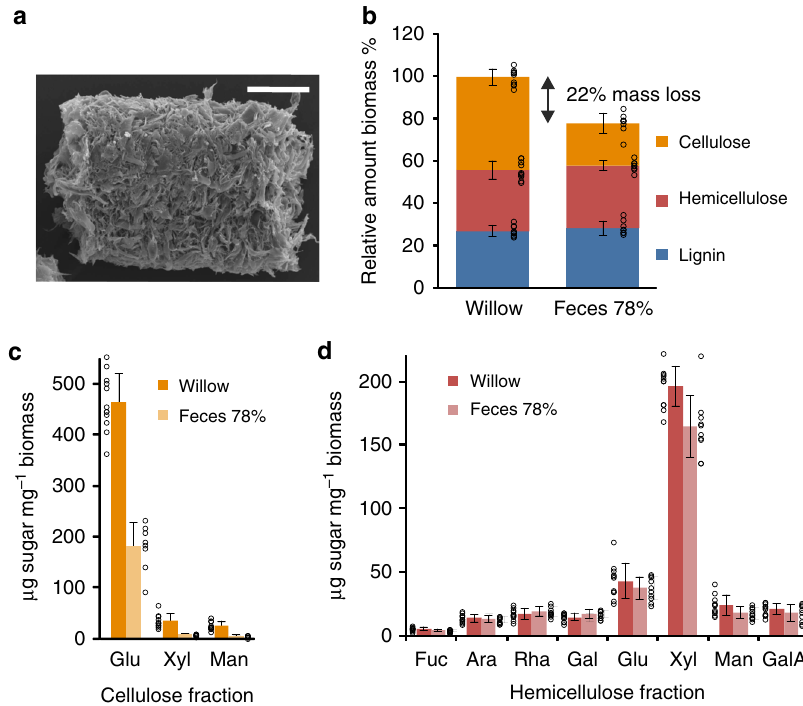
Fig. 1 Major biopolymer composition of willow wood before and after digestion. a Scanning electron micrograph of fecal pellet from Limnoria (scale bar, 50 µ m). b Relative amounts of biomass fractions from wood (Willow, N = 10) and fecal pellets (Feces 78%, normalized to mass loss during digestion, N = 8). Fractions comprise acetyl bromide-soluble lignin (blue), TFA-soluble hemicellulose (red), and sulfuric acid-soluble cellulose (orange). c Monosaccharide composition (absolute amount) of cellulose fraction from wood before (Willow, N = 11; dark orange) and after digestion (Feces 78%, normalized to mass loss during digestion, N = 8; light orange) analyzed by sequential H 2 SO 4 hydrolysis following the TFA hydrolysis in d . d Monosaccharide composition (absolute amount) of hemicellulose fraction from wood before (Willow, N = 11; dark red) and after digestion (Feces 78%, normalized to mass loss during digestion, N = 10; light red) analyzed by TFA hydrolysis. Circles represent sample values and bars sample mean ± SD.